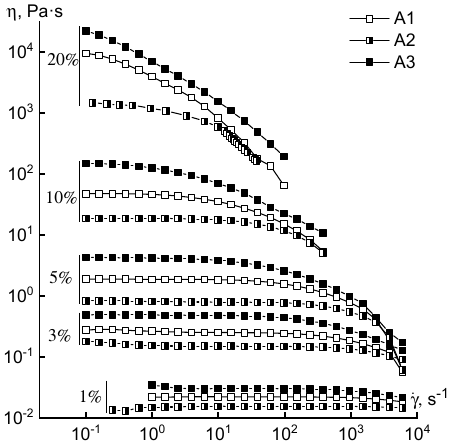
Figure 6. Flow curves of copolymer solutions (series A) of various concentrations (indicated in graphs).